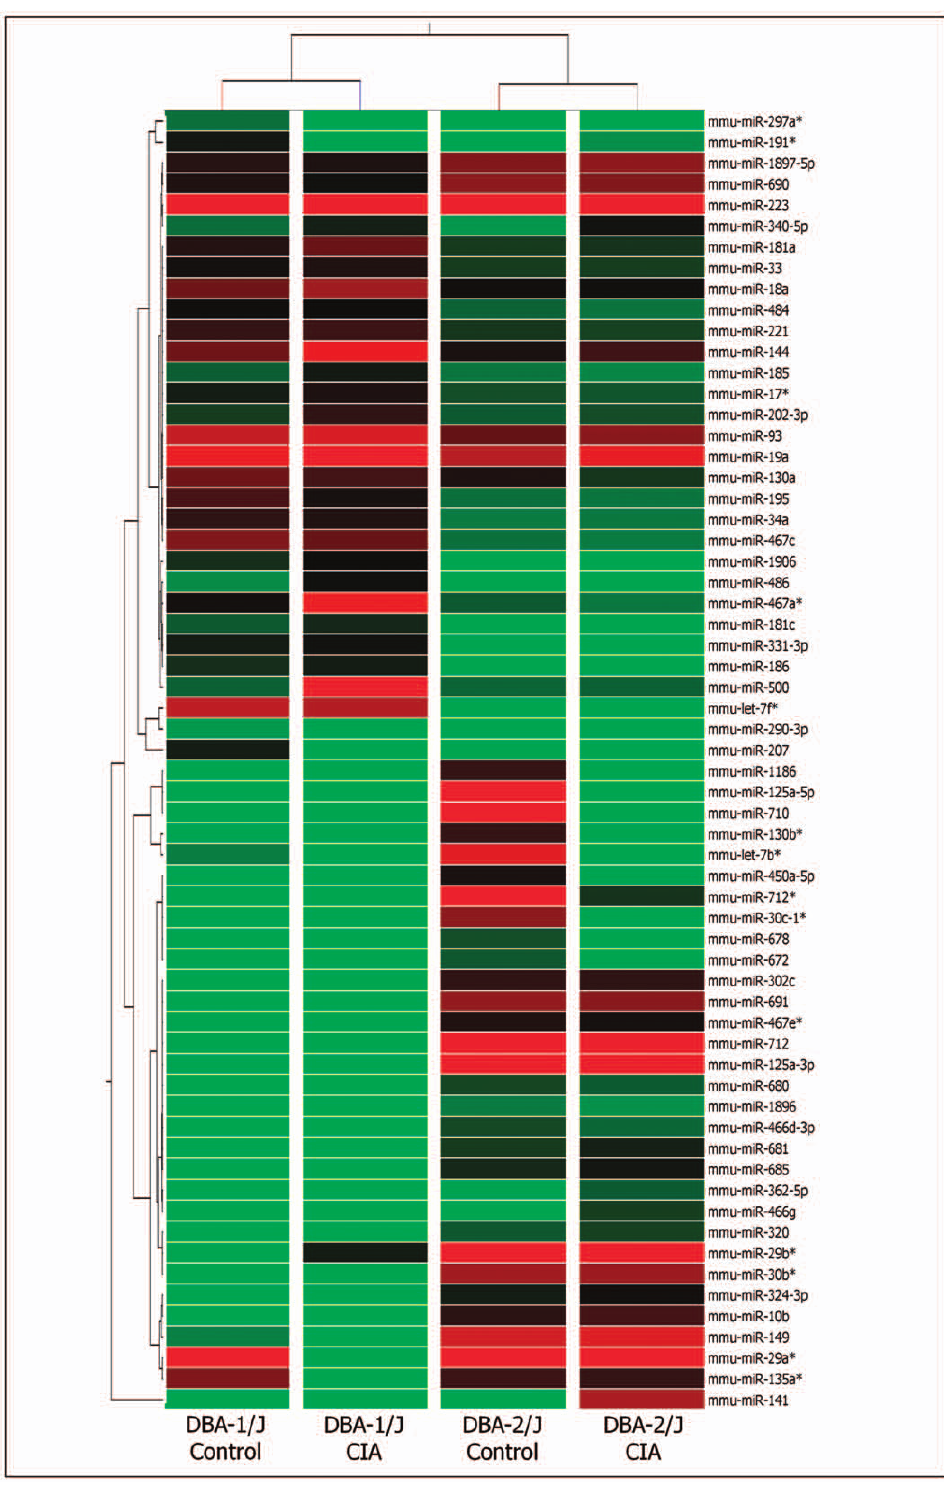
Figure 2. Modulation of miRNAs as evaluated by microarrays during collagen induced arthritis (CIA). Hierarchical clustering and color heat-map of miRNome (miRNAs) of CD3 + T cells from the spleen and lymph nodes of 12-week-old mice from the resistant DBA-2/J and the susceptible DBA-1/J strain, both immunized with chicken type II collagen, based on microarray expression profiling. The control mice were immunized just with complete Freund’s adjuvant (CFA) without any collagen. The dendrogram and heat-map were obtained using cluster and tree- view algorithms through Agilent GeneSpring platform. Heat map legend: Red=up regulation, green=down regulation, black=unmodulated (Pearson correlation metrics).